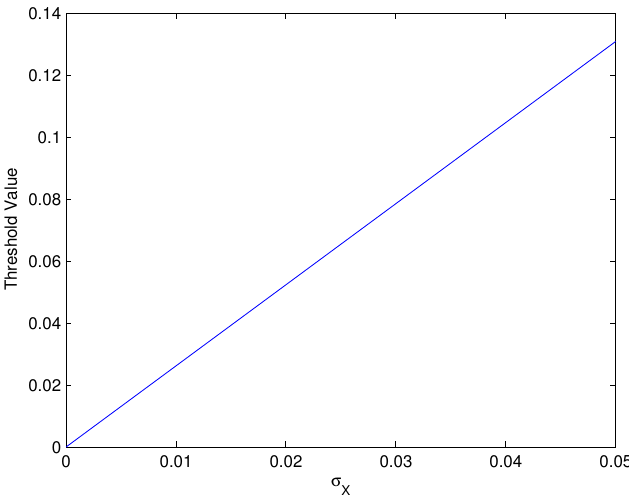
Figure 3. Thresholding for different Gaussian noise